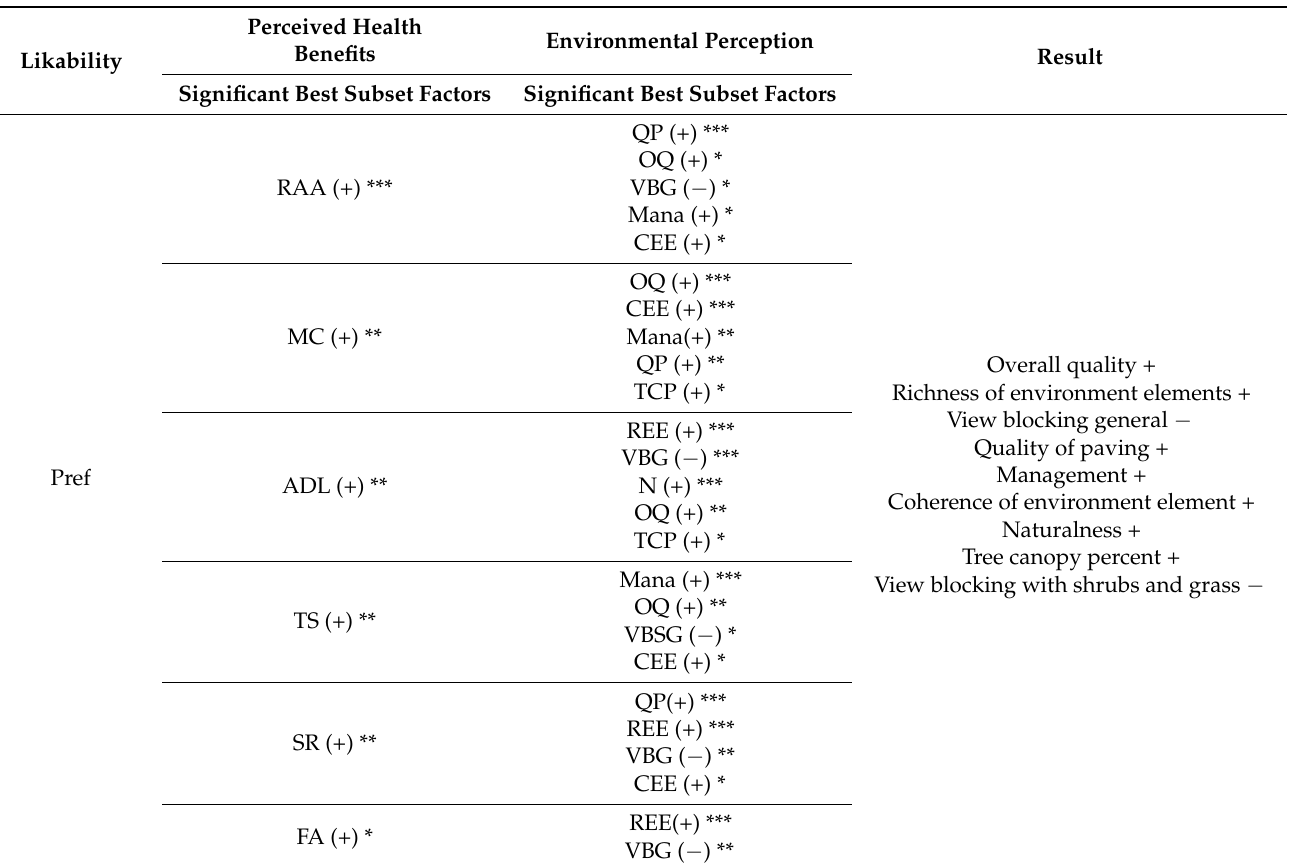
Table 3. Automatic linear models result (*, **, *** represent significance with 0.05, 0.01, and 0.001, respectively; +, − represent positive and negative correlation,